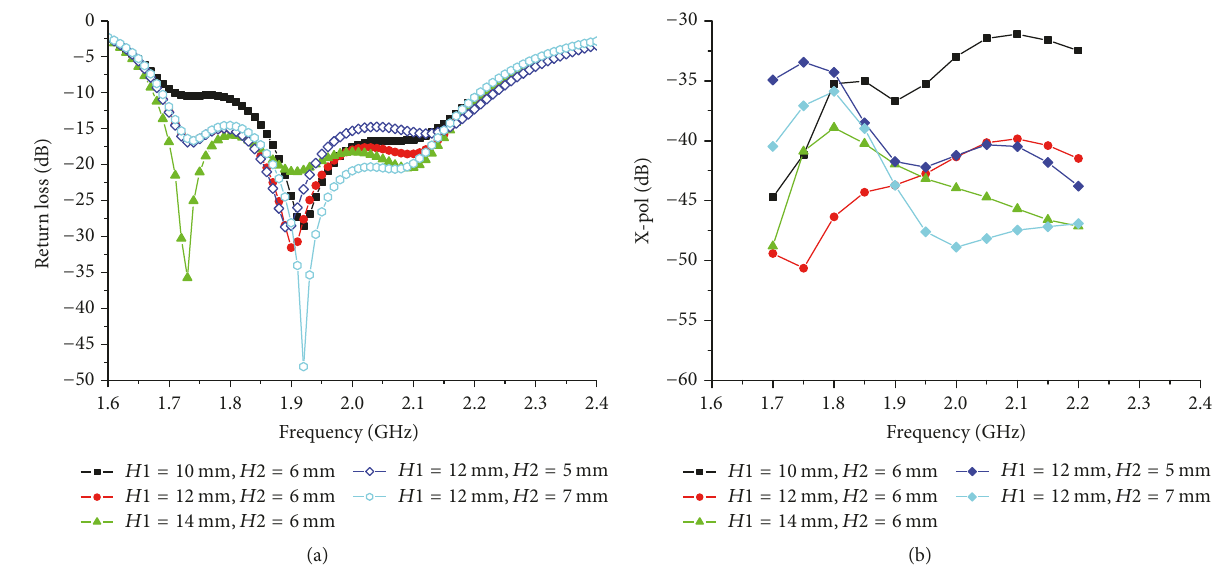
Figure 11: Effect of the parameters 𝐻1 and 𝐻2 . (a) Return loss. (b) Cross-polarization